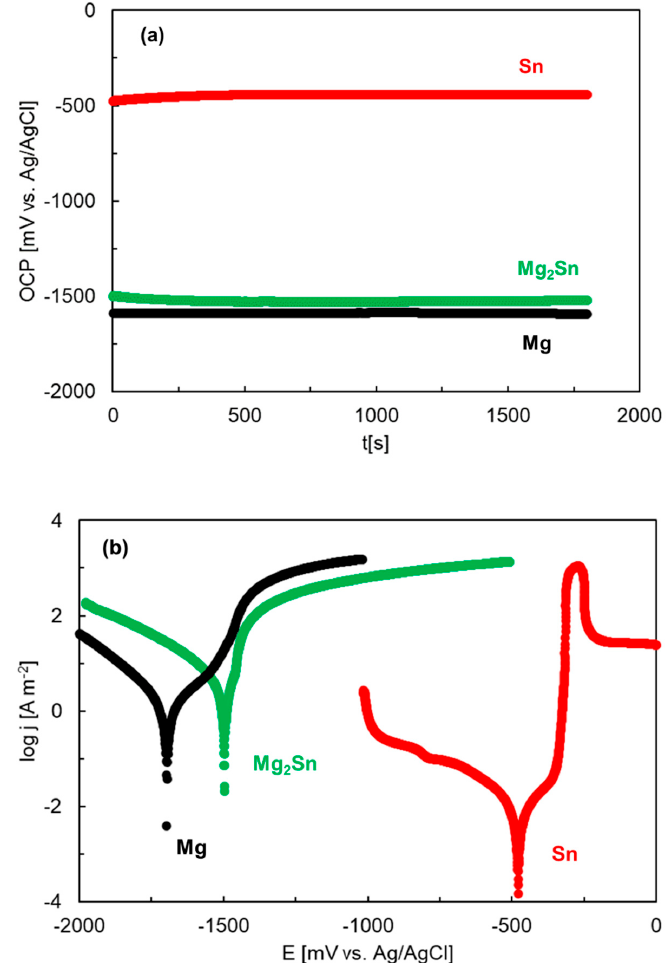
Figure 8. Open circuit potentials ( a ) and polarization curves ( b ) of Mg, Sn and Mg 2 Sn. The experi- ments were conducted in aqueous NaCl solution (3.5 wt.%) at room